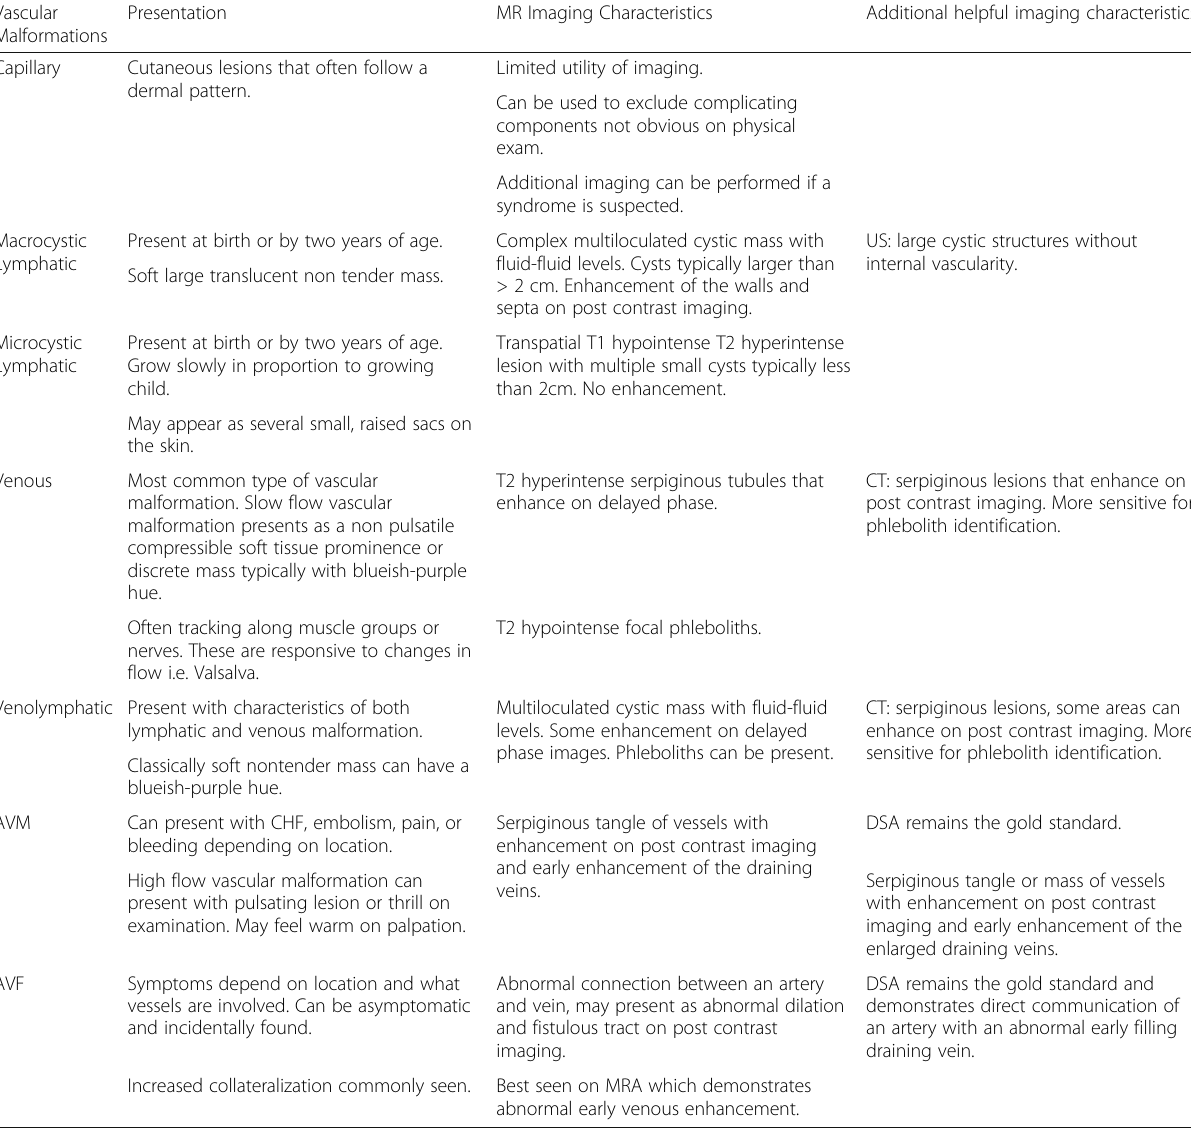
Table 2 Characteristics of vascular malformations Vascular Malformations